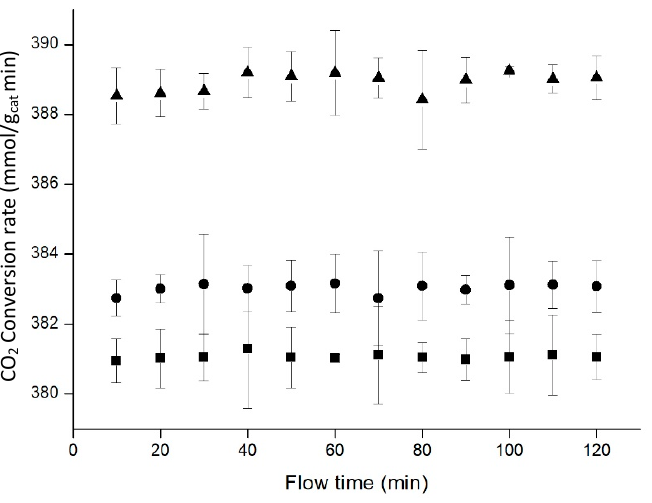
Figure 11. Influence of pressure on the reaction (20 bar ■ , 30 bar •, 50 bar ▲ ). Data points represent the average of three experiments, with error bars corresponding to confidence interval 95%.